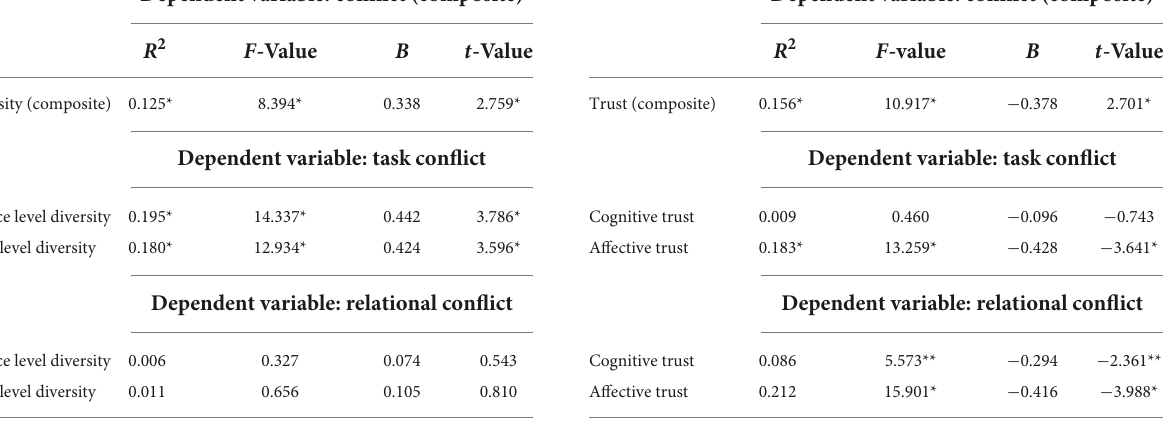
TABLE 3 Summaries of regression analyses (diversity and conflict). TABLE 4 Summaries of regression analyses (trust and conflict).